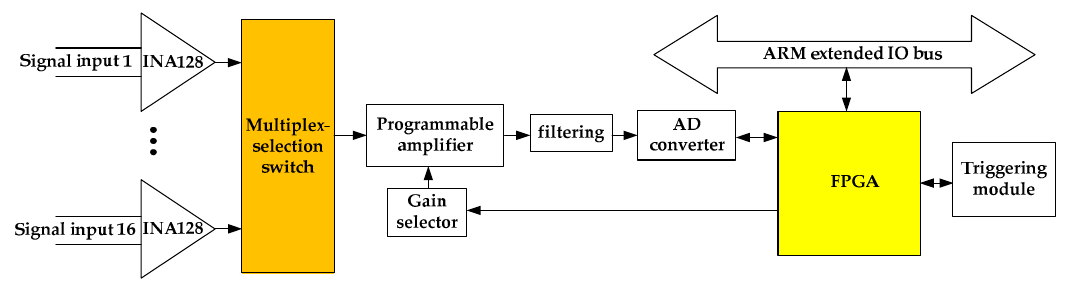
Figure 6. Schematic diagram of the multi-channel signal acquisition module.